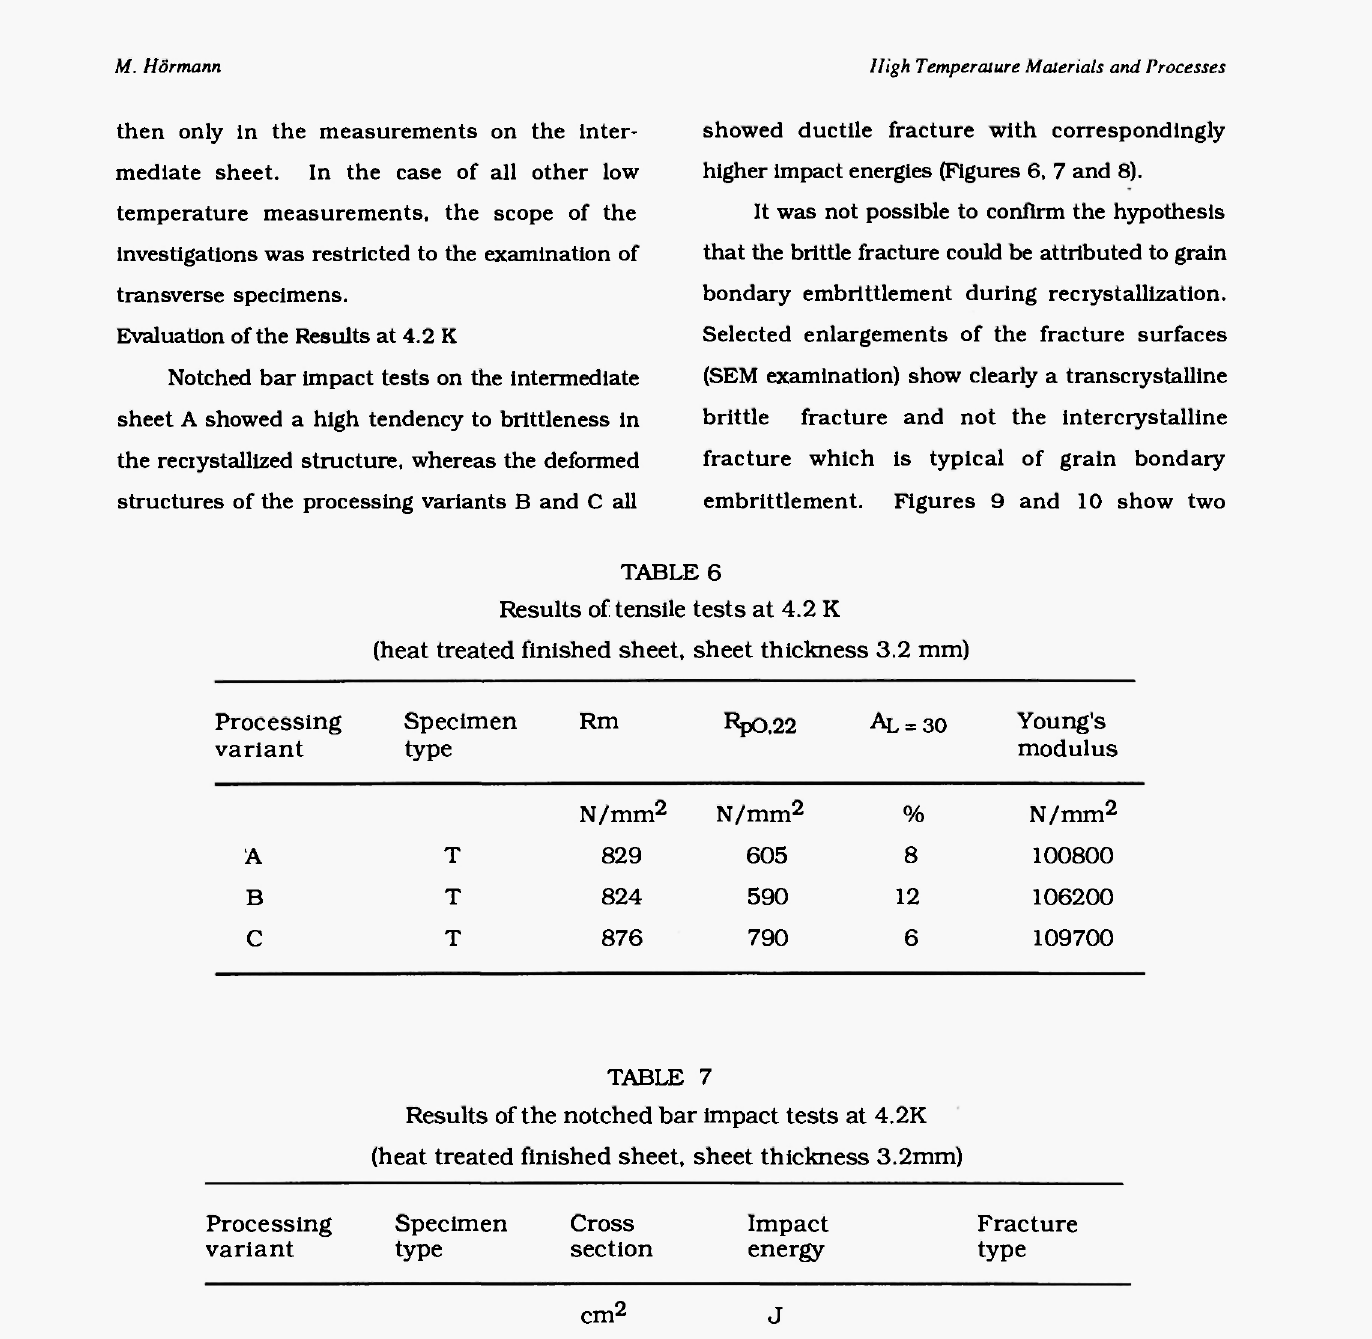
Results of the notched bar impact tests at 4.2K (heat treated finished sheet, sheet thickness